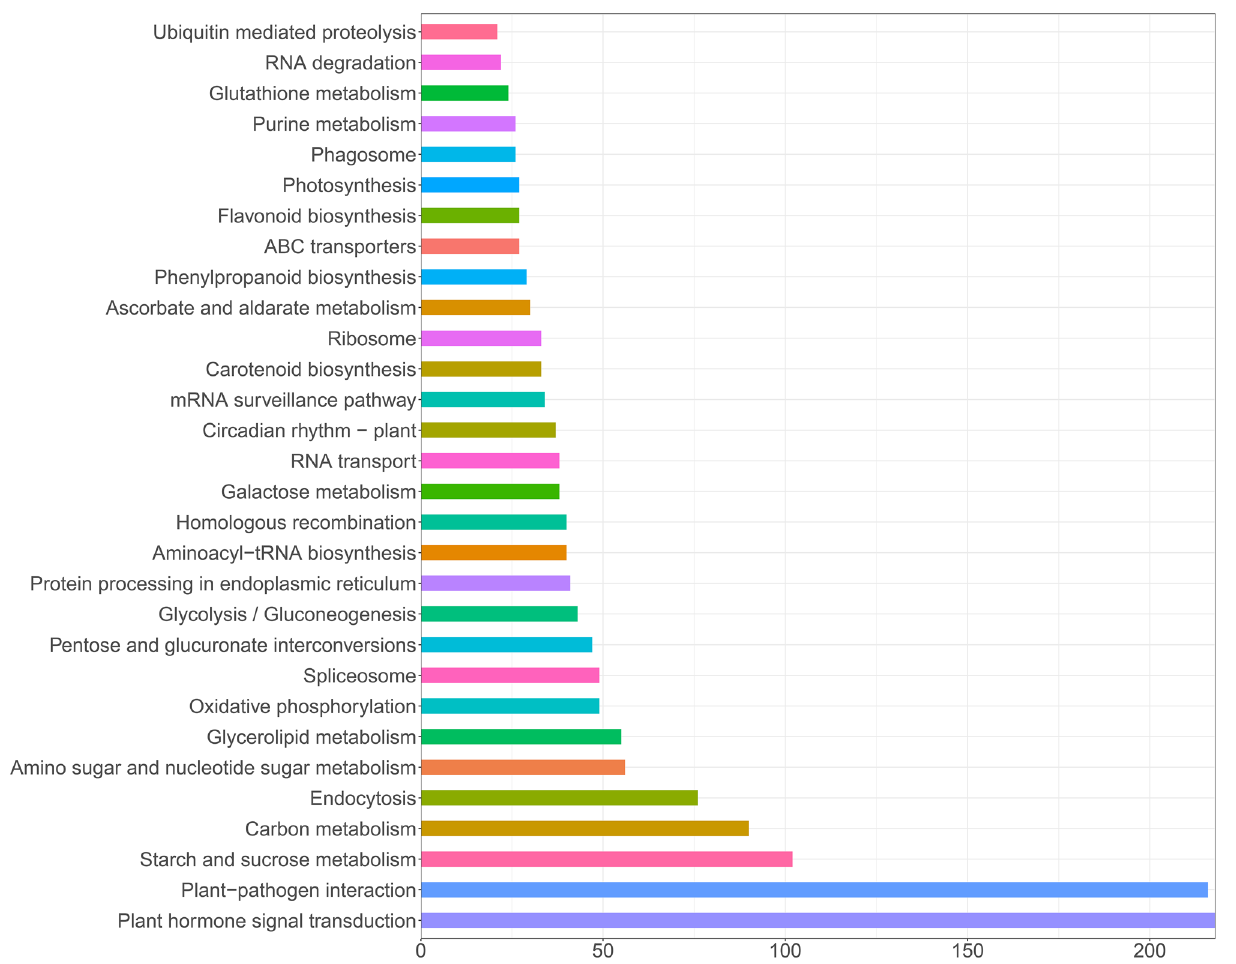
Figure 6. KEGG pathway enrichment analysis of DEGs drawn by ggplot2 (v3.3.3). X-axis represents the number of genes; Y-axis represents the name of KEGG pathway: the different colour represents different KEGG